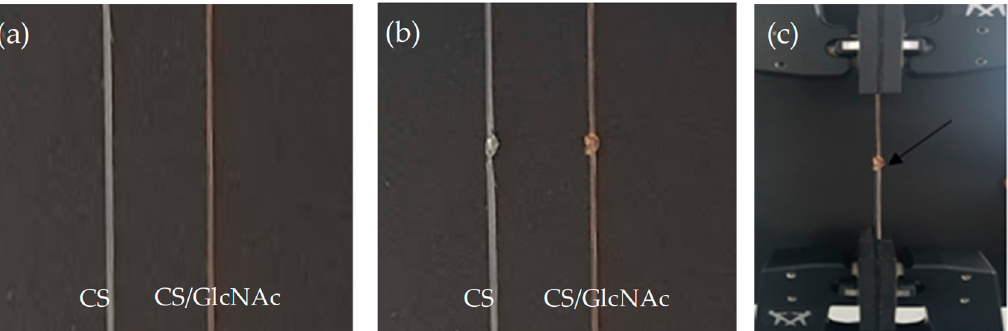
Figure 2. Filaments of CS and CS / GlcNAc: non-knotted ( a ); knotted; ( b ) and placed in the Instron machine with the knot approximately midway between the clamps ( c ).